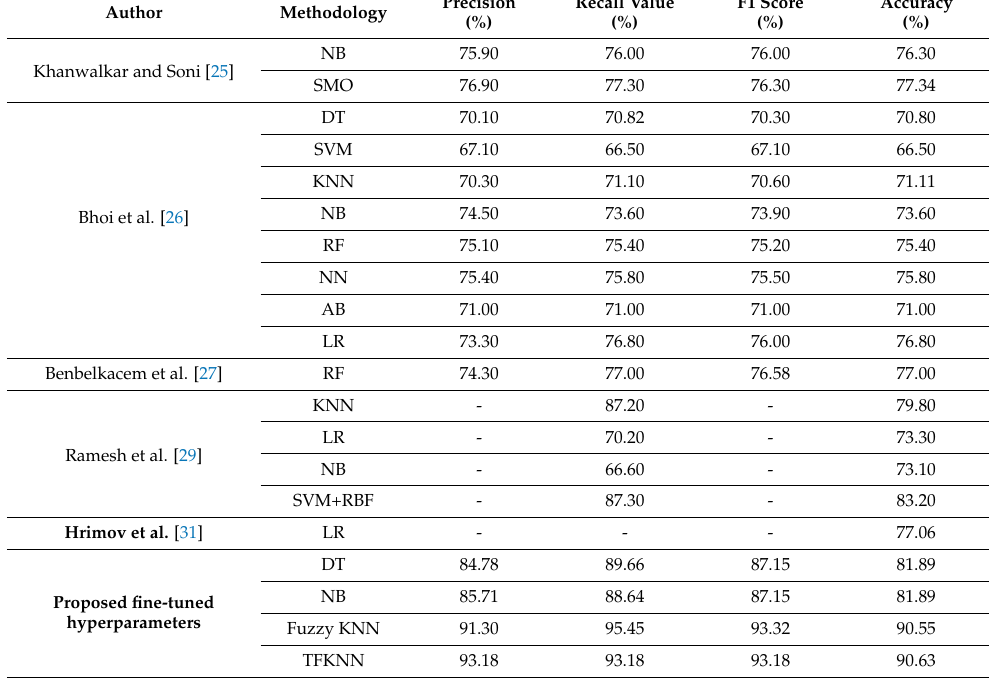
Table 12. The comparative evaluation results of the proposed model with the recent approaches in terms of precision, recall, F1 score, and accuracy for the applied PIDD